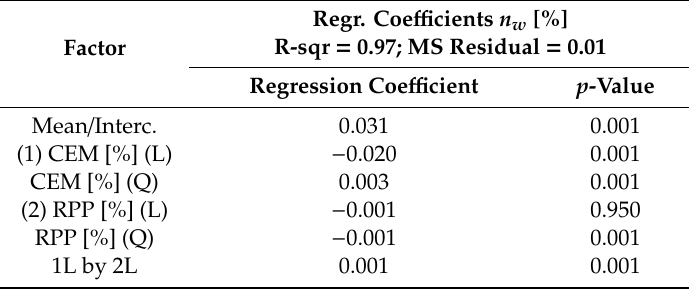
Table 9. Experimental coe ffi cients for water absorption n w.